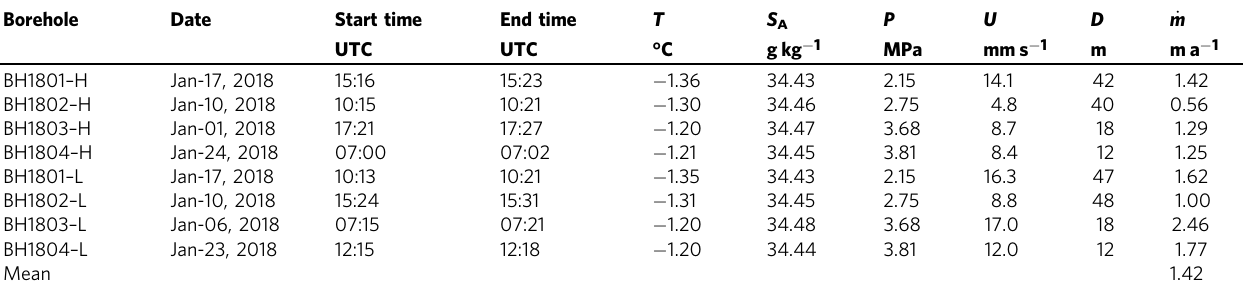
Table 2 Summary of in situ observations in the ice – ocean boundary layer: mean temperature ( T ), absolute salinity ( S A ), pressure ( P ), current ( U ) averaged within the ice – ocean boundary layer ( D ), and computed basal-melt rate ( _ m ). Borehole